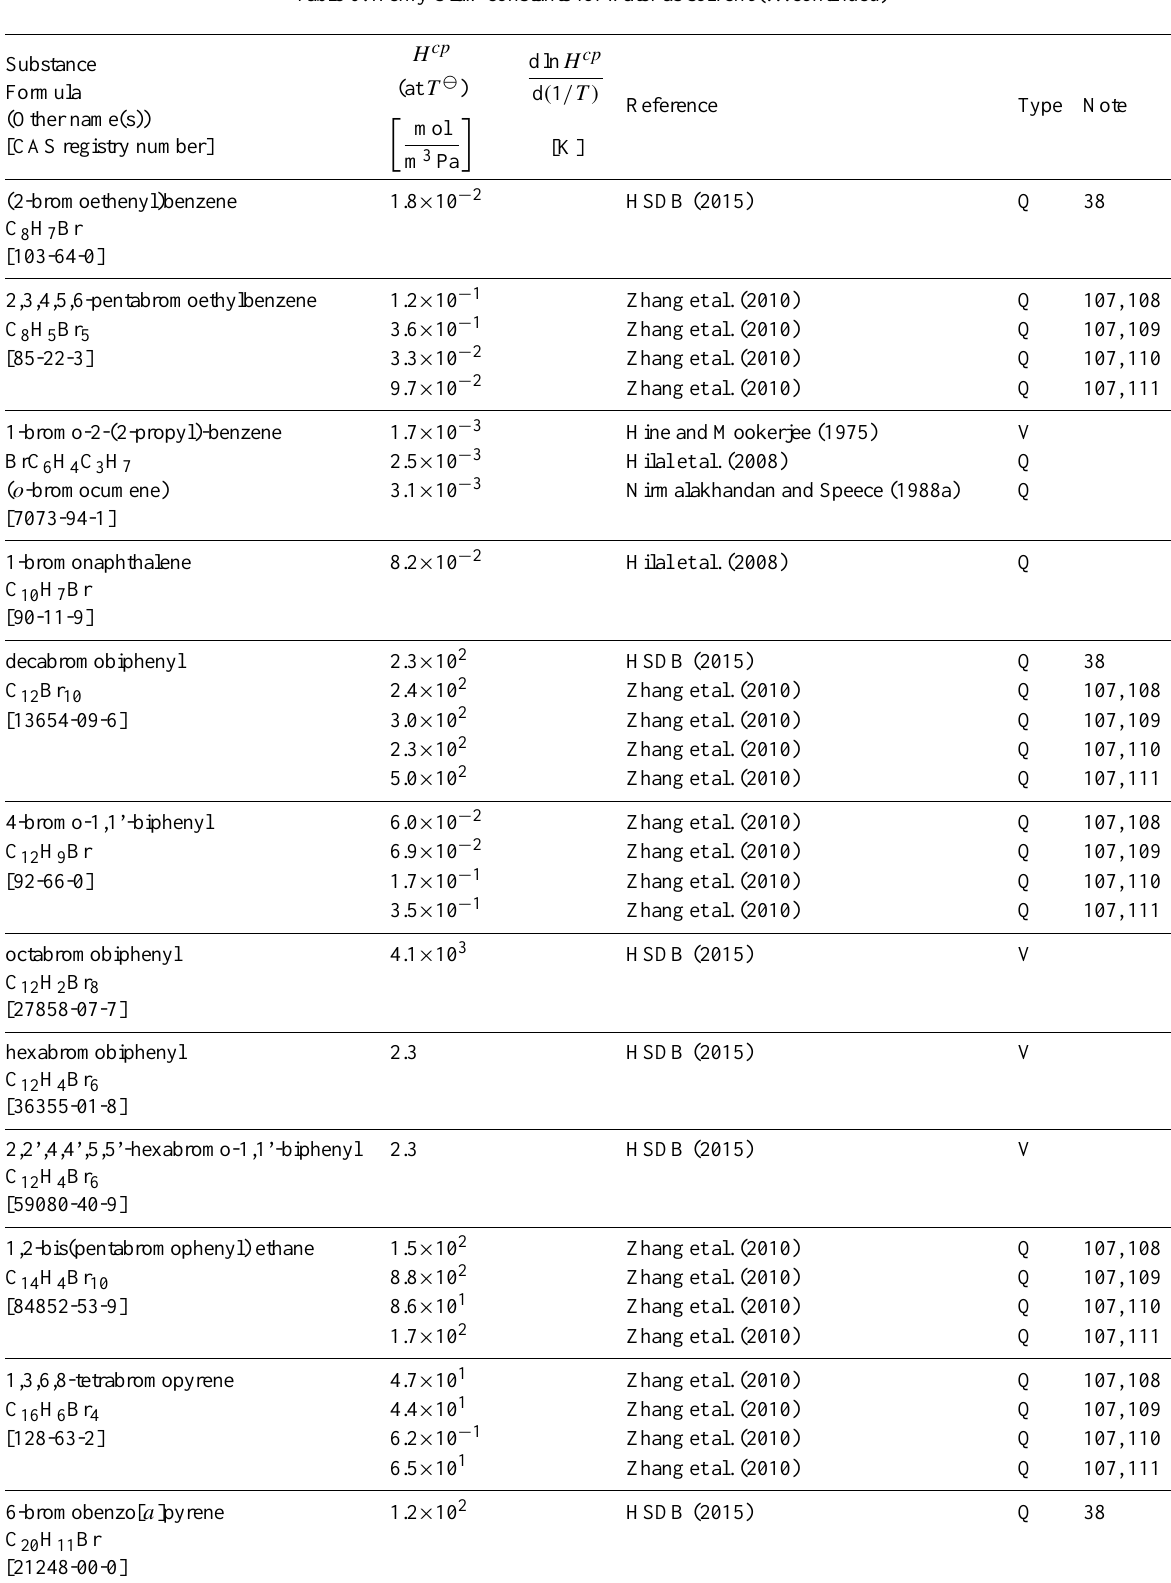
Table 6: Henry’s law constants for water as solvent